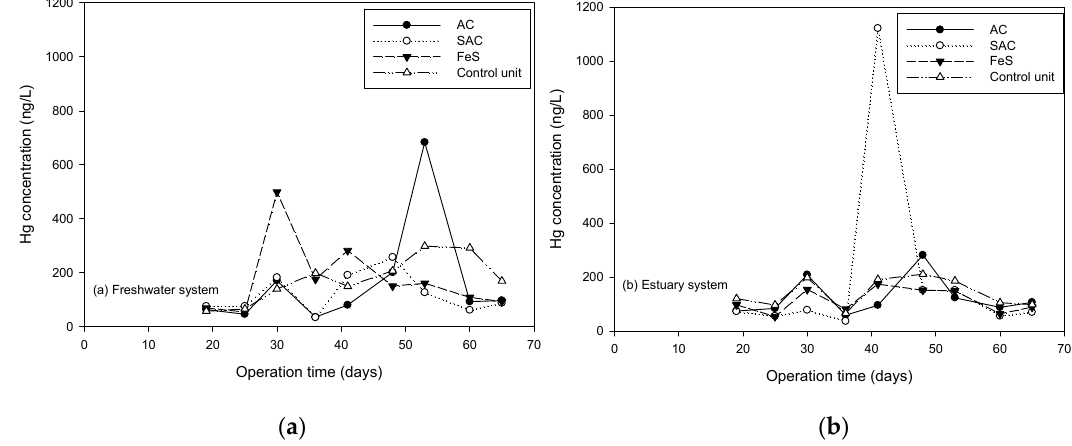
Figure 7. THg concentration in overlying water of ( a ) freshwater system and ( b ) estuary system